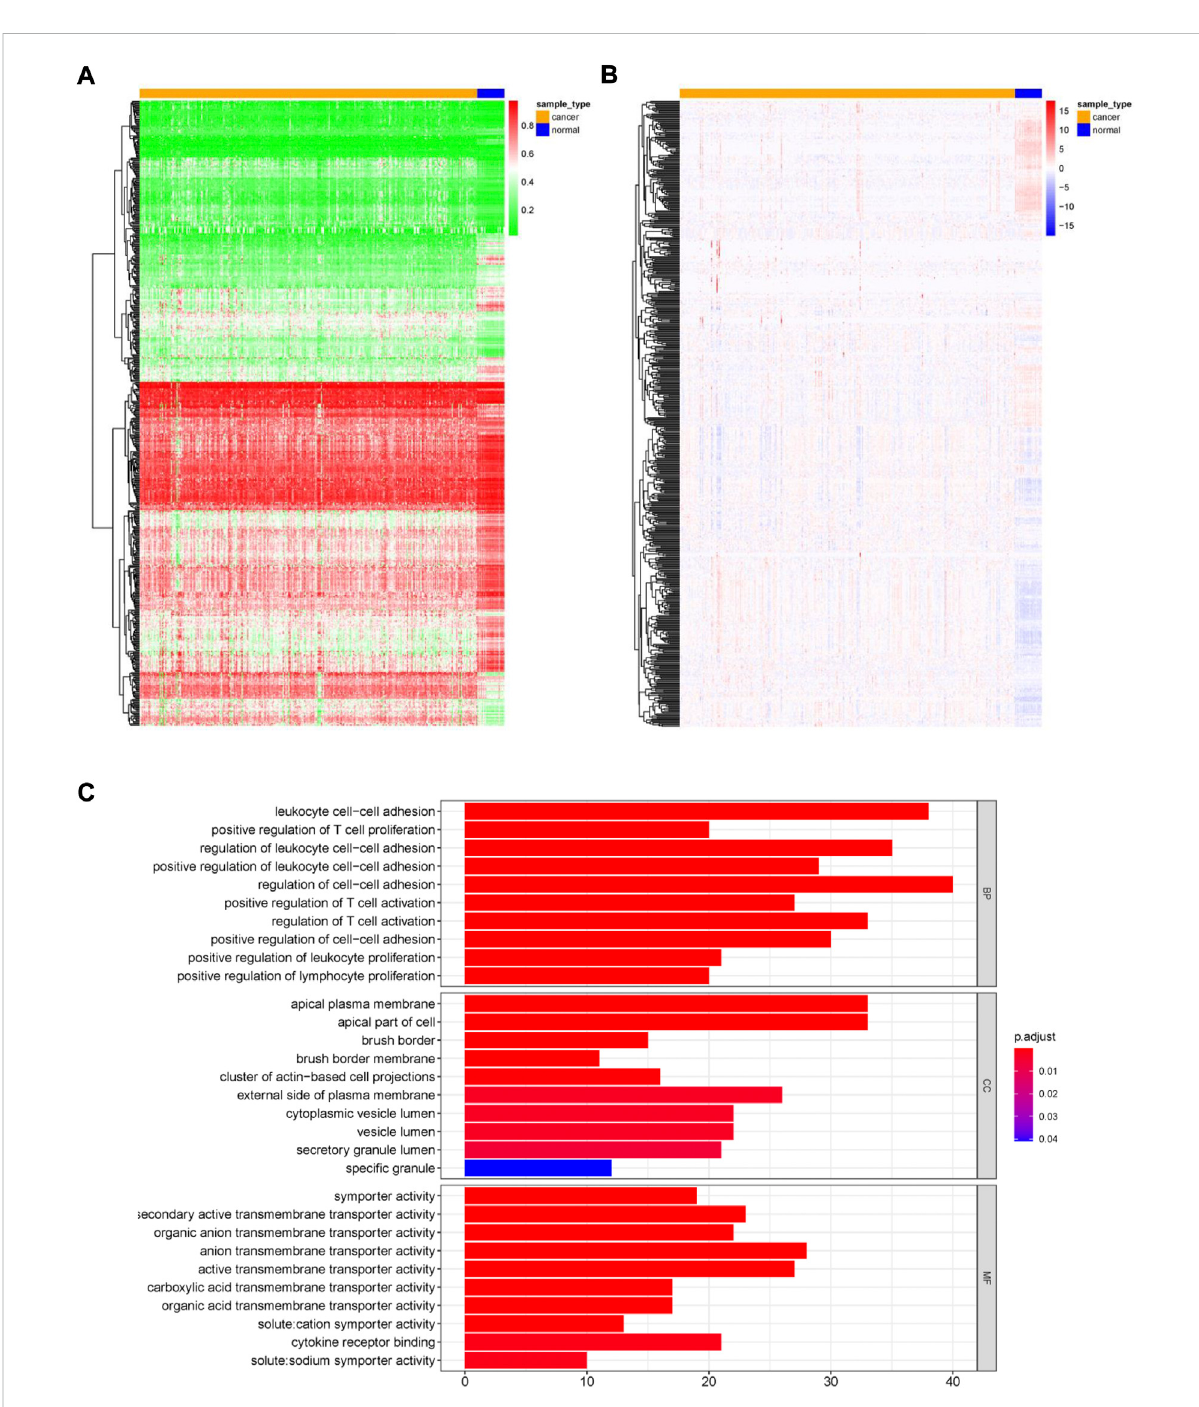
FIGURE 2 Overview of methylation driven genes in ccRCC. (A) Heatmap of methylation levels of 560 methylation-driven genes. (B) Heatmap of gene expression levels of 560 methylation-driven genes. (C) GO analysis of 560 methylation-driven